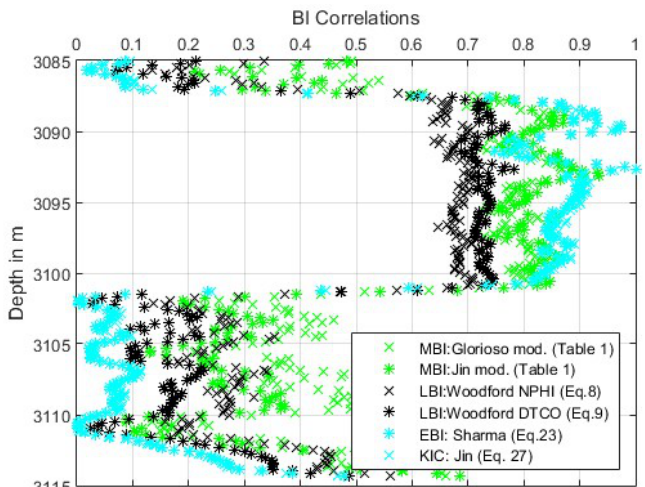
Figure 6. BI correlations from the middle Bakken formation applied over depth. Black colors show LBI correlations, green colors modified MBI correlations (Table 4), and blue colors indicate EBI correlations. The interval from 3087.5 to 3102 m depth shows the middle Bakken formation. It shows a clear trend to the upper and lower Bakken since the clay content in these formations is significantly higher [42].